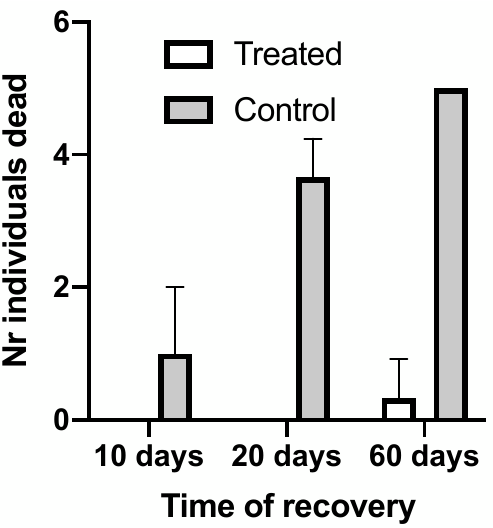
Figure 3. Mortality rates recorded in treated (single bath of 15 min) and control specimens, as averages of three replicates of five individuals each. The readings were performed three times during the recovery period, with clean seawater in recirculated tanks. Averages were evaluated on three replicates of five individuals, along with standard deviations among replicates (indicated by vertical bars).